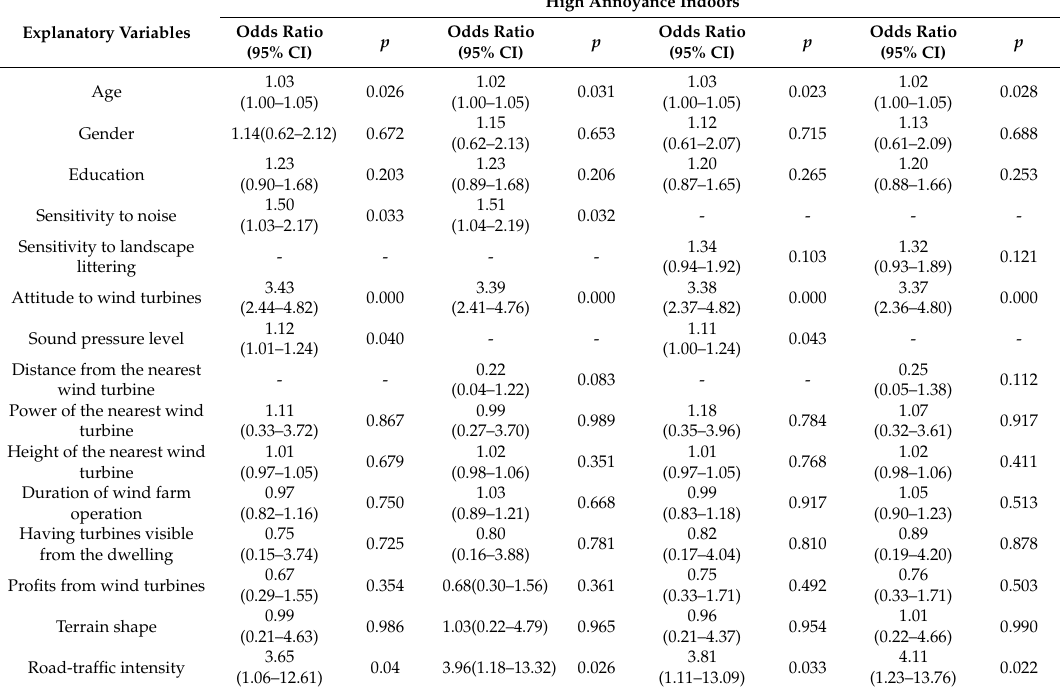
Table 9. Association between perception indoors of high annoyance related to the wind turbine noise (dependent, binary variable) and the calculated A-weighted sound pressure level (or distance) as well as subjective (individual) and objective factors (independent variables) tested by logistic regression.